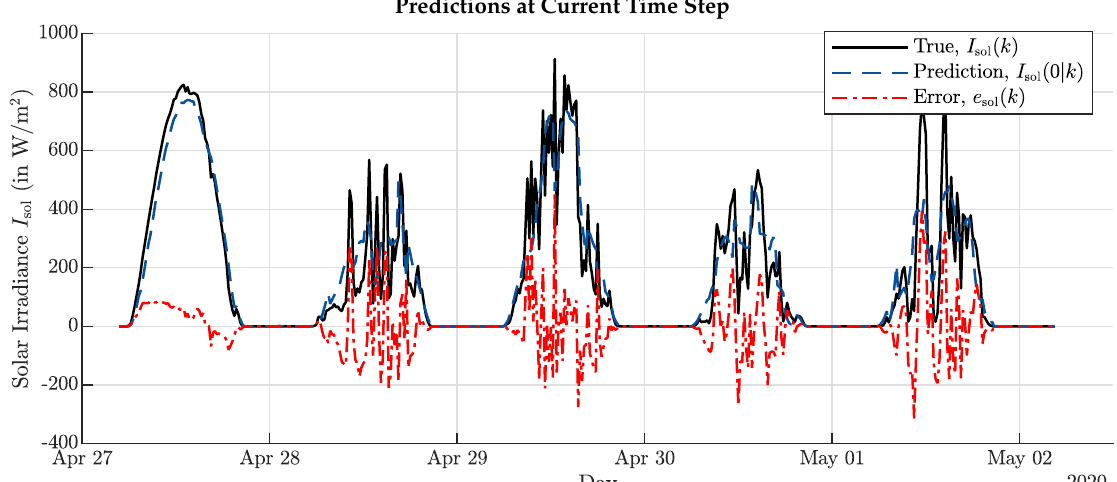
Figure 4. Exemplary comparison of true solar irradiance (black line) and most recent predictions available at the beginning of a time step (blue line) for 5 days. Besides forecasts being up to 65min old, significant differences may occur due to the local distance between the site and the next weather station used for